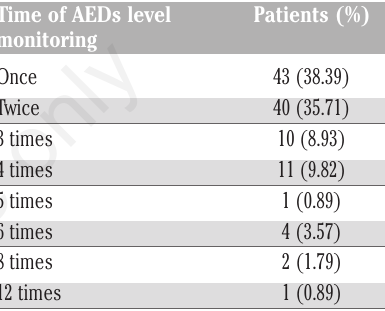
Table 1. Numbers of time of antiepileptic drugs (AEDs) level monitoring.